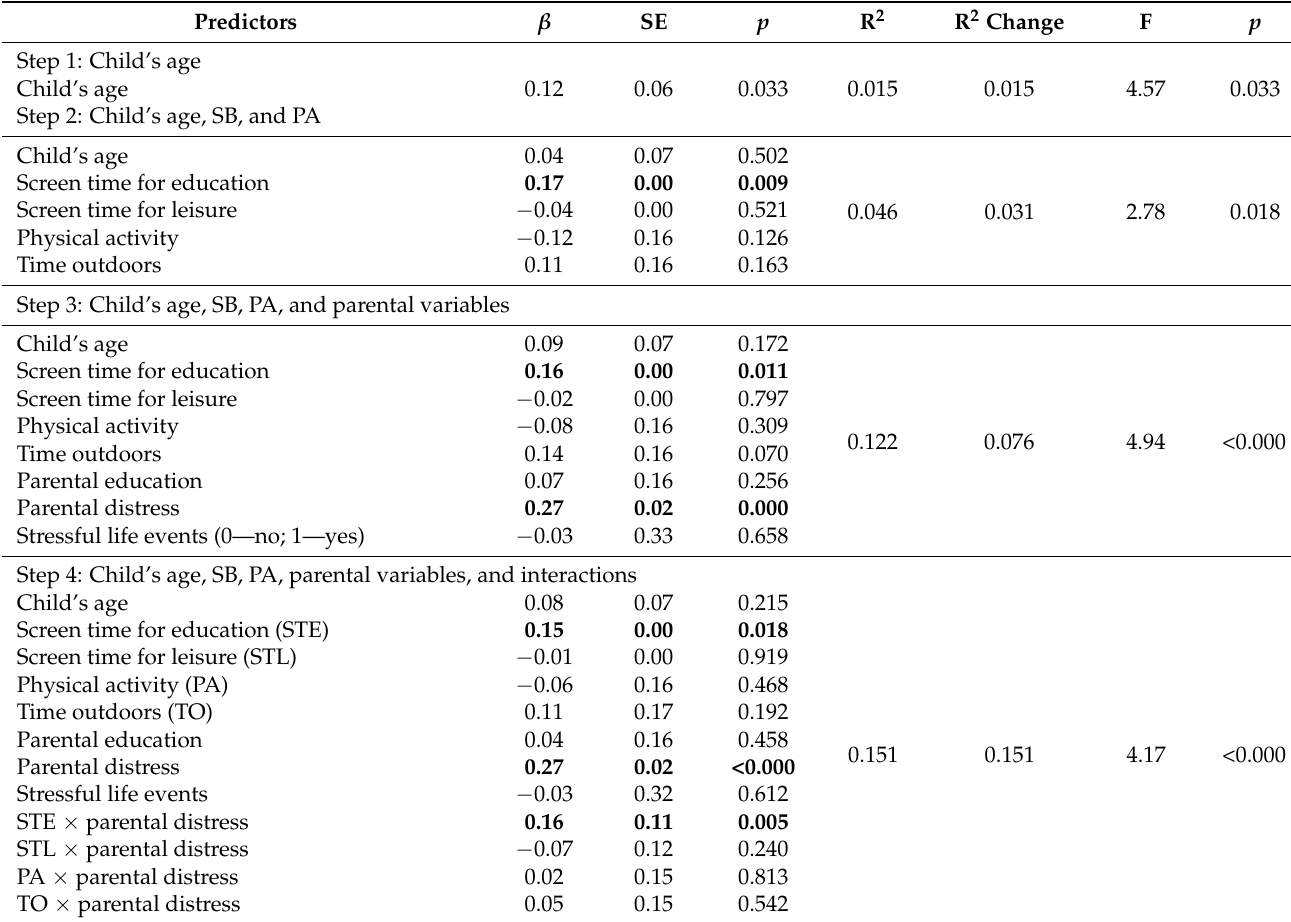
Table 3. Hierarchical linear regression models predicting children’s somatic symptoms.